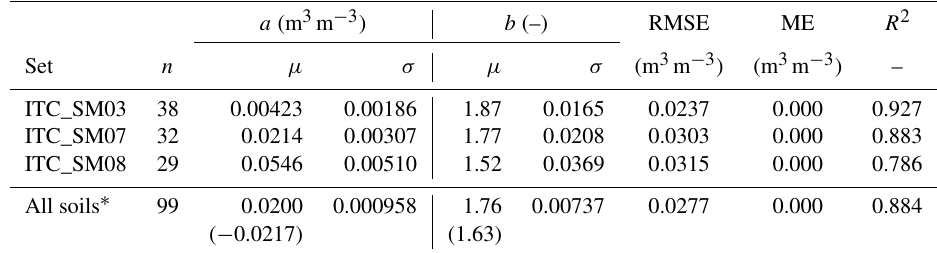
Figure 4. (a) Measurements of GVSM against 5TM VSM on soil collected at sites ITC_SM03, ITC_SM07, and ITC_SM08, and (b) calibrated 5TM VSM against GVSM measurements performed for the same soils as in (a) . Table 1. Mean ( µ ) regression coefficients and their standard deviations ( σ ) fitted through pairs of GVSM and 5TM VSM measured in the laboratory on soil collected at sites ITC_SM03, ITC_SM07, and ITC_SM08. Performance metrics, RMSE, ME, and R 2 , follow from the validation. n stands for the number of